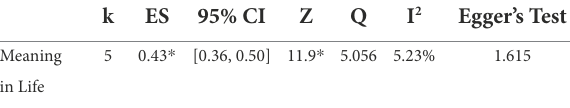
TABLE 3 Mean effect sizes of meaning in life in posttraumatic growth.